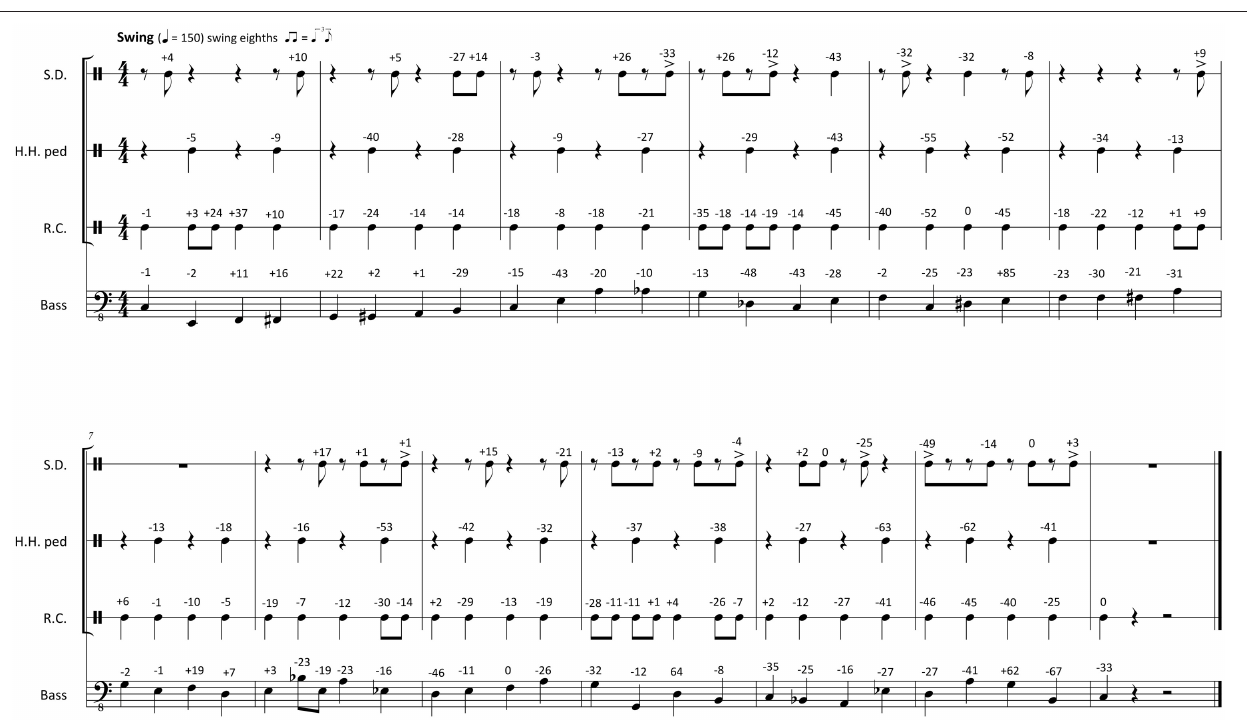
FIGURE 1 | Transcription of the recorded 12-bar Swing pattern used as a basis for the timing manipulations. Originally performed timing deviations from metronomic time are indicated in milliseconds (negative numbers, event is ahead of the metronome; positive number, event sounds later than the metronome); S.D., snare drum; H.H. ped, foot-operated hi-hat cymbal; R.C., ride